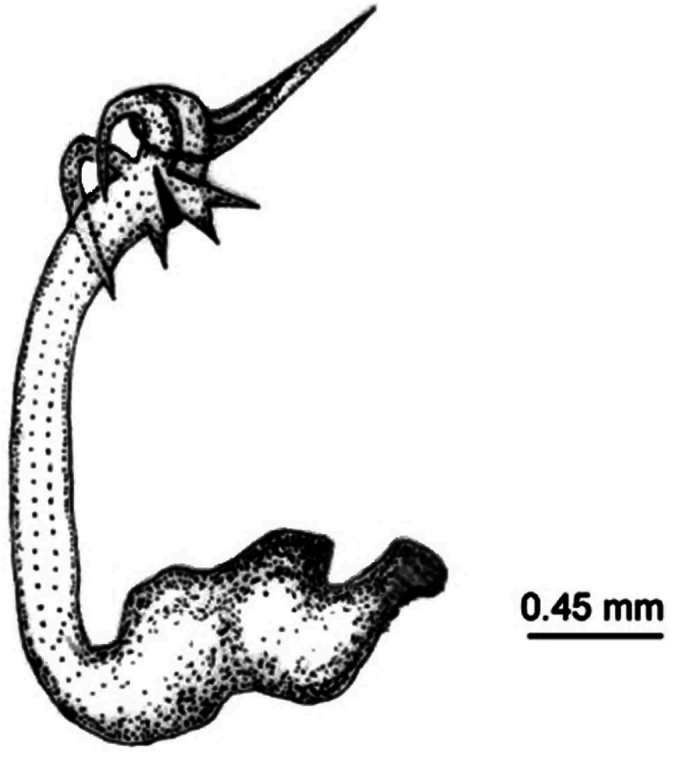
Cicadatra platyptera, aedeagus (scale= 0.45 mm).